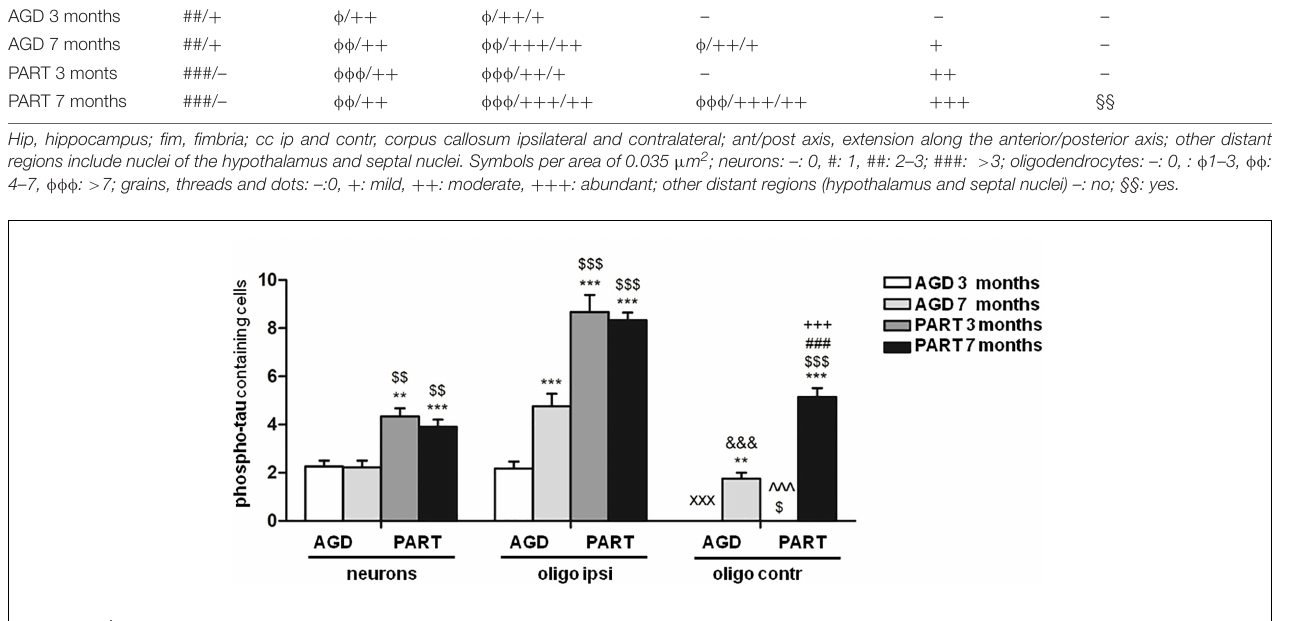
FIGURE 6 | Numbers of neurons in the hippocampus, oligodendrocytes in the ipsilateral corpus callosum, and oligodendrocytes in the contralateral corpus in the four groups of mice inoculated with sarkosyl-insoluble fractions of AGD and PART with 3 months and 7 months of survival. Counts were compared with two-way analysis of variance (ANOVA) followed by Tukey post-test using SPSS software. Differences are considered statistically significant at ** P < 0.01 and *** P < 0.001 compared with AGD 3 months; $ P < 0.05, $$ P < 0.01, and $$$ P < 0.001 compared with AGD 7 months; and ### P < 0.001 compared with PART 3 months. Comparison between values of oligodendrocytes in ipsilateral (ipsi) and contralateral (contr) corpus callosum was assessed using T-student test and SPSS software. Differences are considered statistically significant at xxx P < 0.001 compared with AGD 3 months ipsi; &&& P < 0.001 compared with AGD 7 months ipsi; ˆˆˆ P < 0.001 compared with PART 3 months ipsi; and +++ P < 0.001 compared with PART 7 months